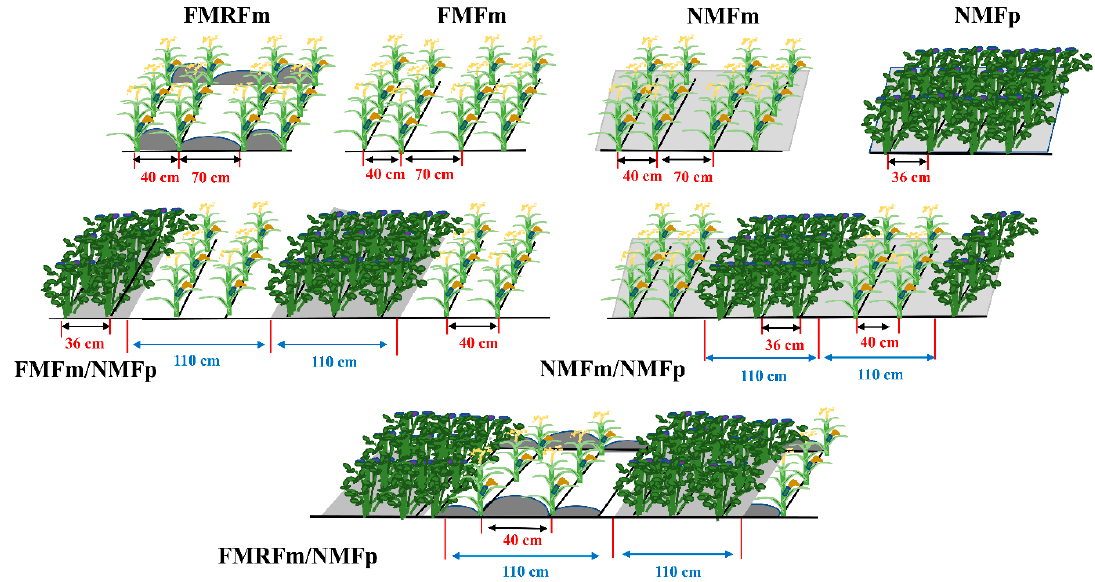
Figure 1. Diagram of the different maize-potato intercropping systems at the Rainfed Agricultural Experiment Station of Gansu Agricultural University, Dingxi City (35°28 ′ N, 104°44 ′ E), Gansu Province, China. FMRF, film mulched ridge-furrow plot; FMF, film mulched flat plot; NMF, no mulching flat plot; m, maize; p, potato.